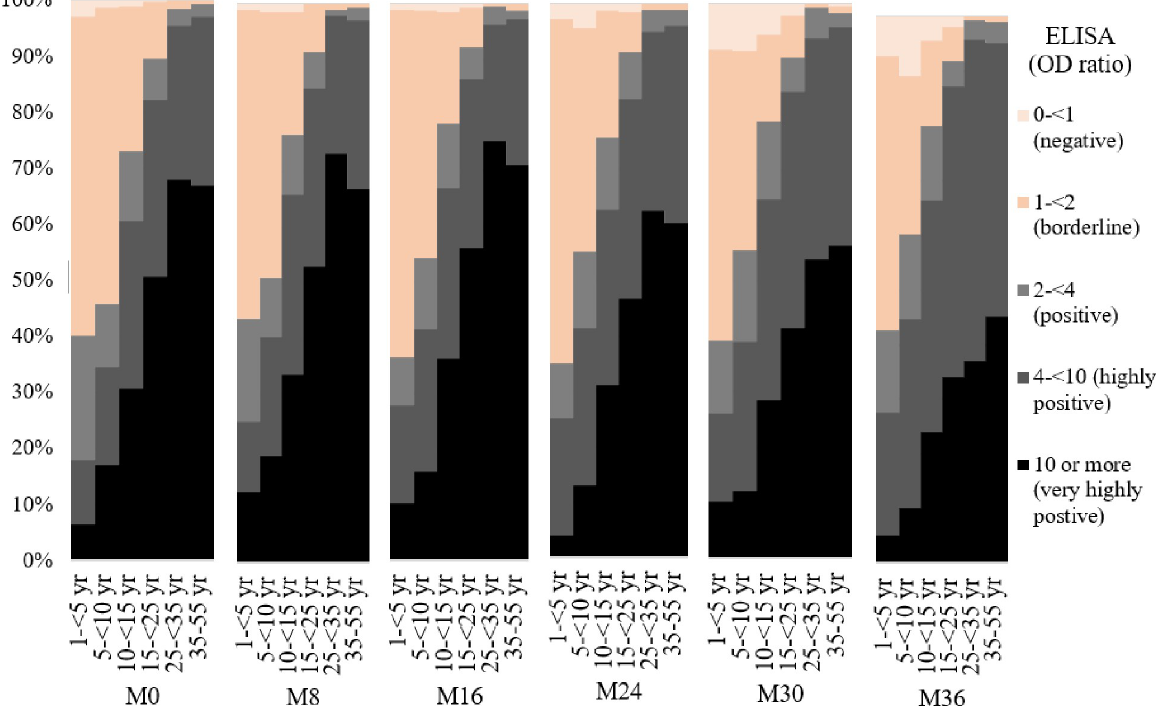
Fig 1. Proportion of dengue IgG seropositivity by age group for each serosurvey visit. Legend: Percentage of DENV seroprevalence based on indirect dengue IgG ELISA OD level. Axis X represent age group and the serosurvey visit Axis Y represent proportion of dengue IgG